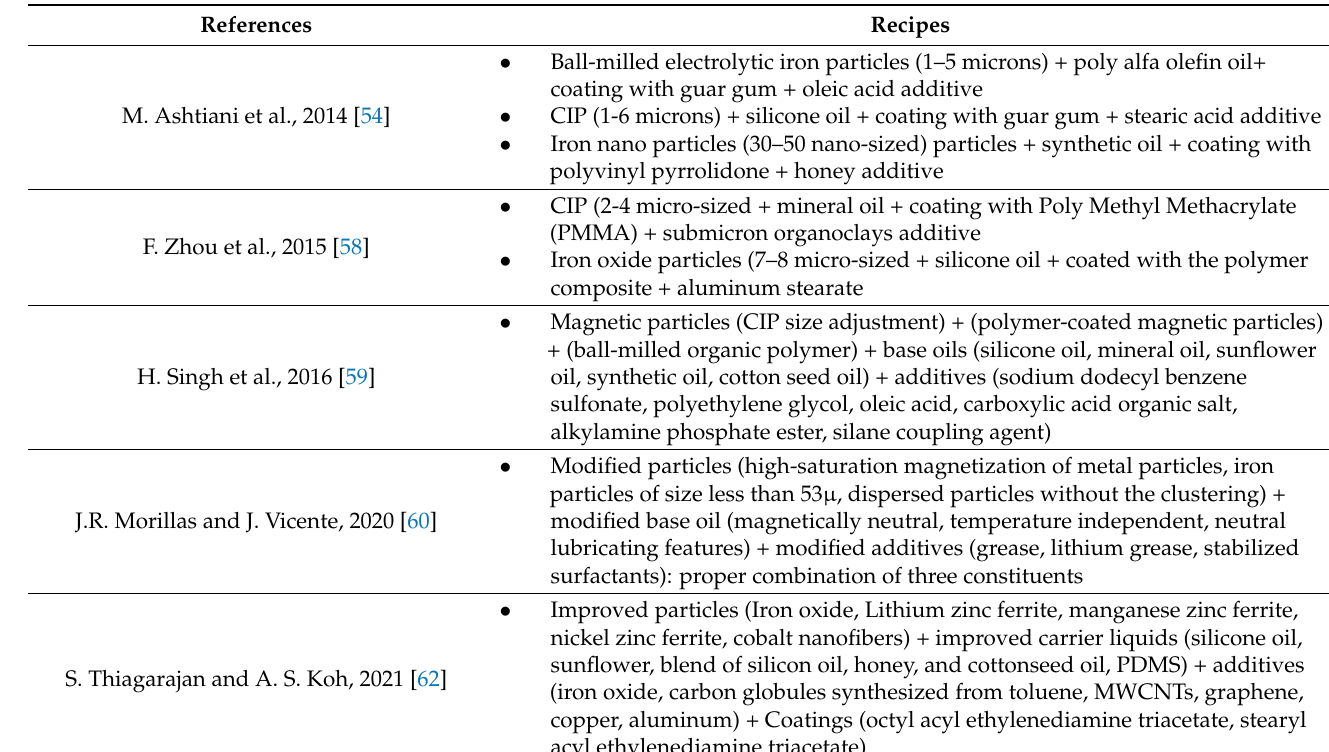
Table 4. Combined Methods to Improve the Sedimentation